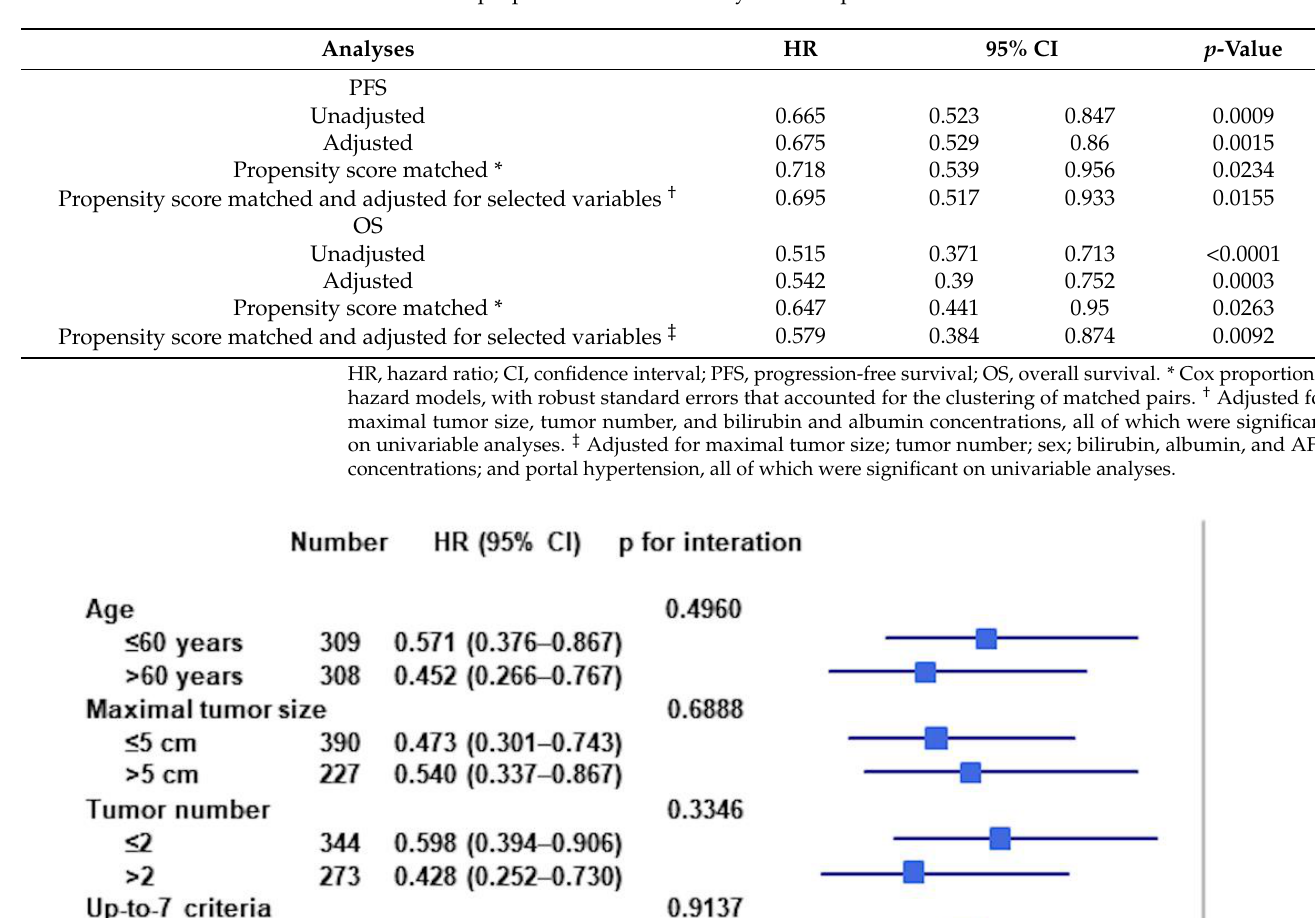
Table 2. Cox proportional hazards analyses of SR plus IORFA versus TACE on PFS and OS.